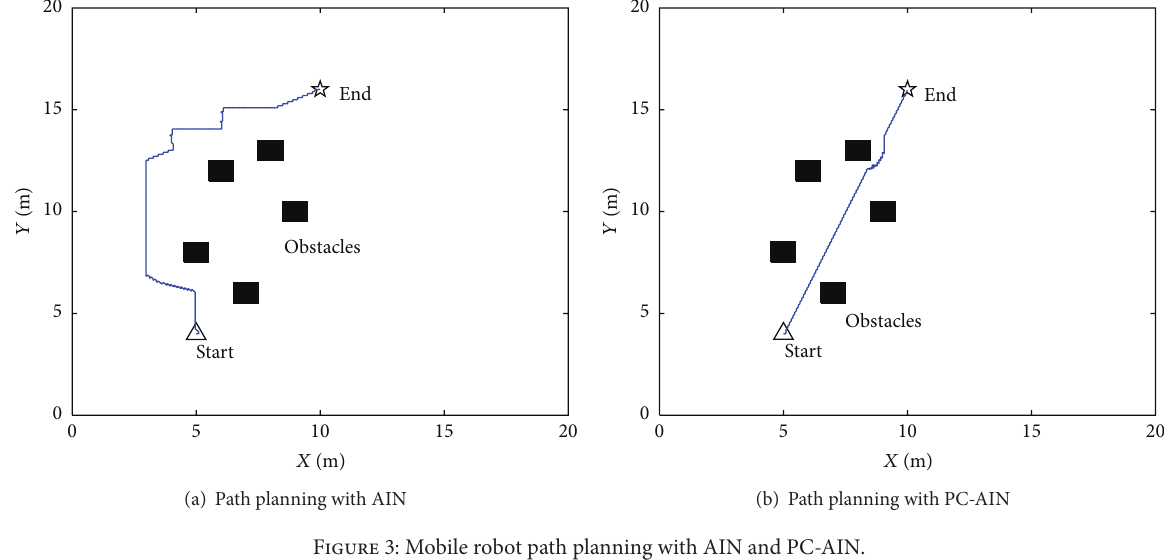
Figure 3: Mobile robot path planning with AIN and PC-AIN.